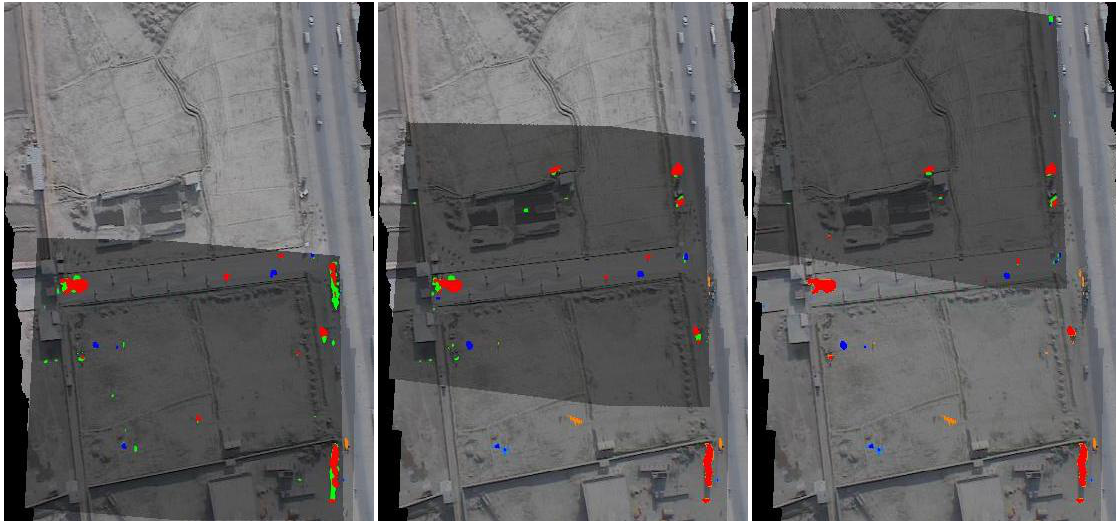
Figure 4: Change detection results for the overflights over the scene access point from Fig. 1: Changes between previous and current video frame for three different points in time (left, center, and right image) with the overlapping area of current and previous video frame (darkened) and the reference video mosaic as background. In the progress of time, the overlapping area sweeps from the bottom to the top and the mosaic gets updated by the overlapping area and by the reference change mask “behind” it. The change mask colors correspond to Figure 2. The additional colors light blue and light red in the reference change mask indicate less significant changes. (cid:15) Since change detection between image pairs is not